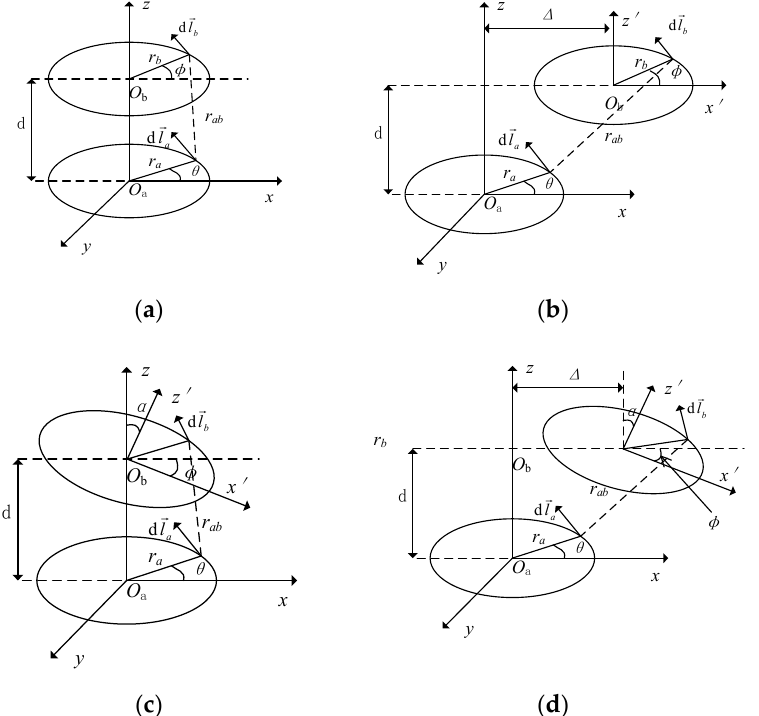
Figure 3. Schematic diagram of coil offset: ( a ) ideal alignment; ( b ) radial offset; ( c ) angular offset; ( d ) angular and radial offset.